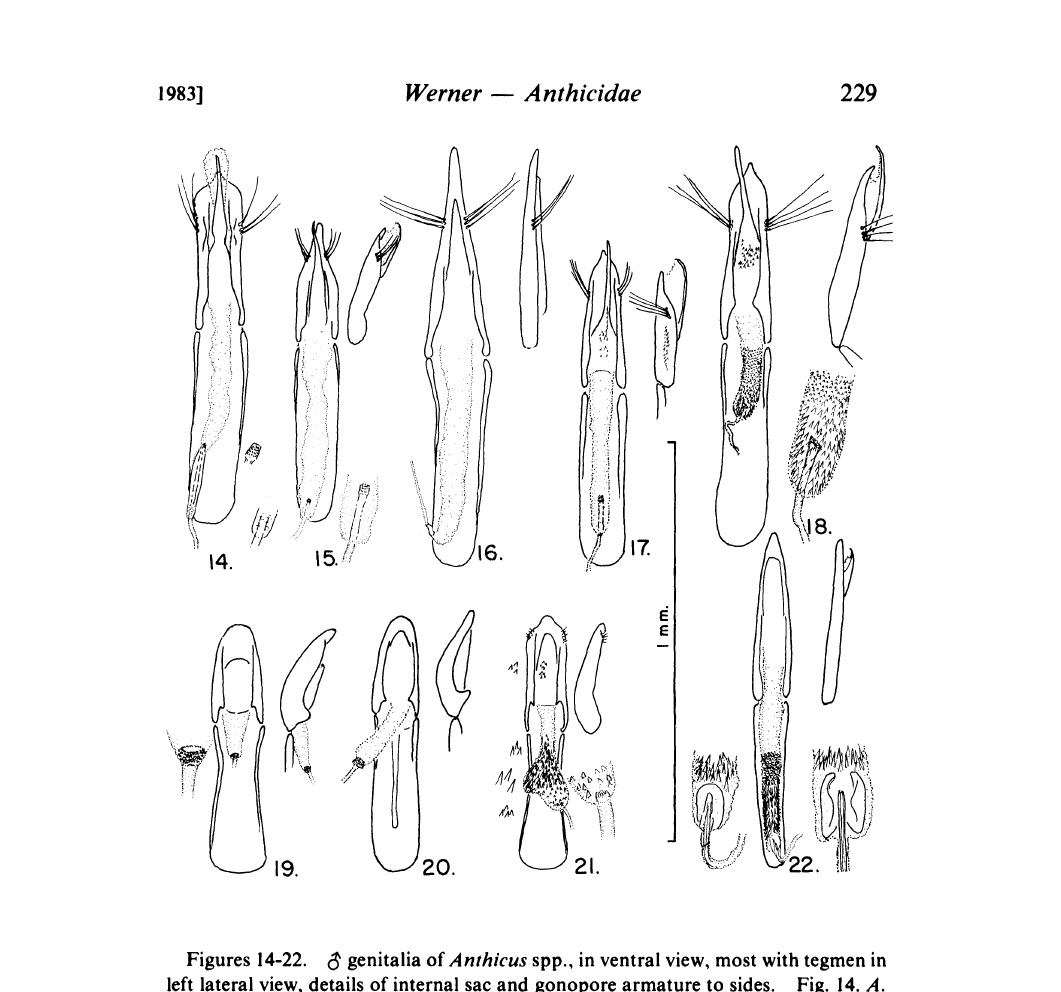
Figures 14-22. genitalia of Anthicus spp., in ventral view, most with tegmen in left lateral view, details of internal sac and gonopore armature to sides. Fig. 14. A. so&dad, paratype, Soledad, Cuba. Fig. 15. A. macgillavryL Soledad, Cuba. Fig. 16. A. hispaniolae, paratype. Fig. 17. A. darlingtoni, paratype, Damien, Haiti. Fig. 18. A. subtilis, Villa Altagracia, Rep. Dom. Fig. 19. A. antilleorum, paratype, Cayamas, Cuba. Fig. 20. A. margaritae, paratype, Carupano, Venez. Fig. 21. A. blackwelderL paratype, Kingston, Jam. Fig. 22. A. russoL Boca Chica, Rep.